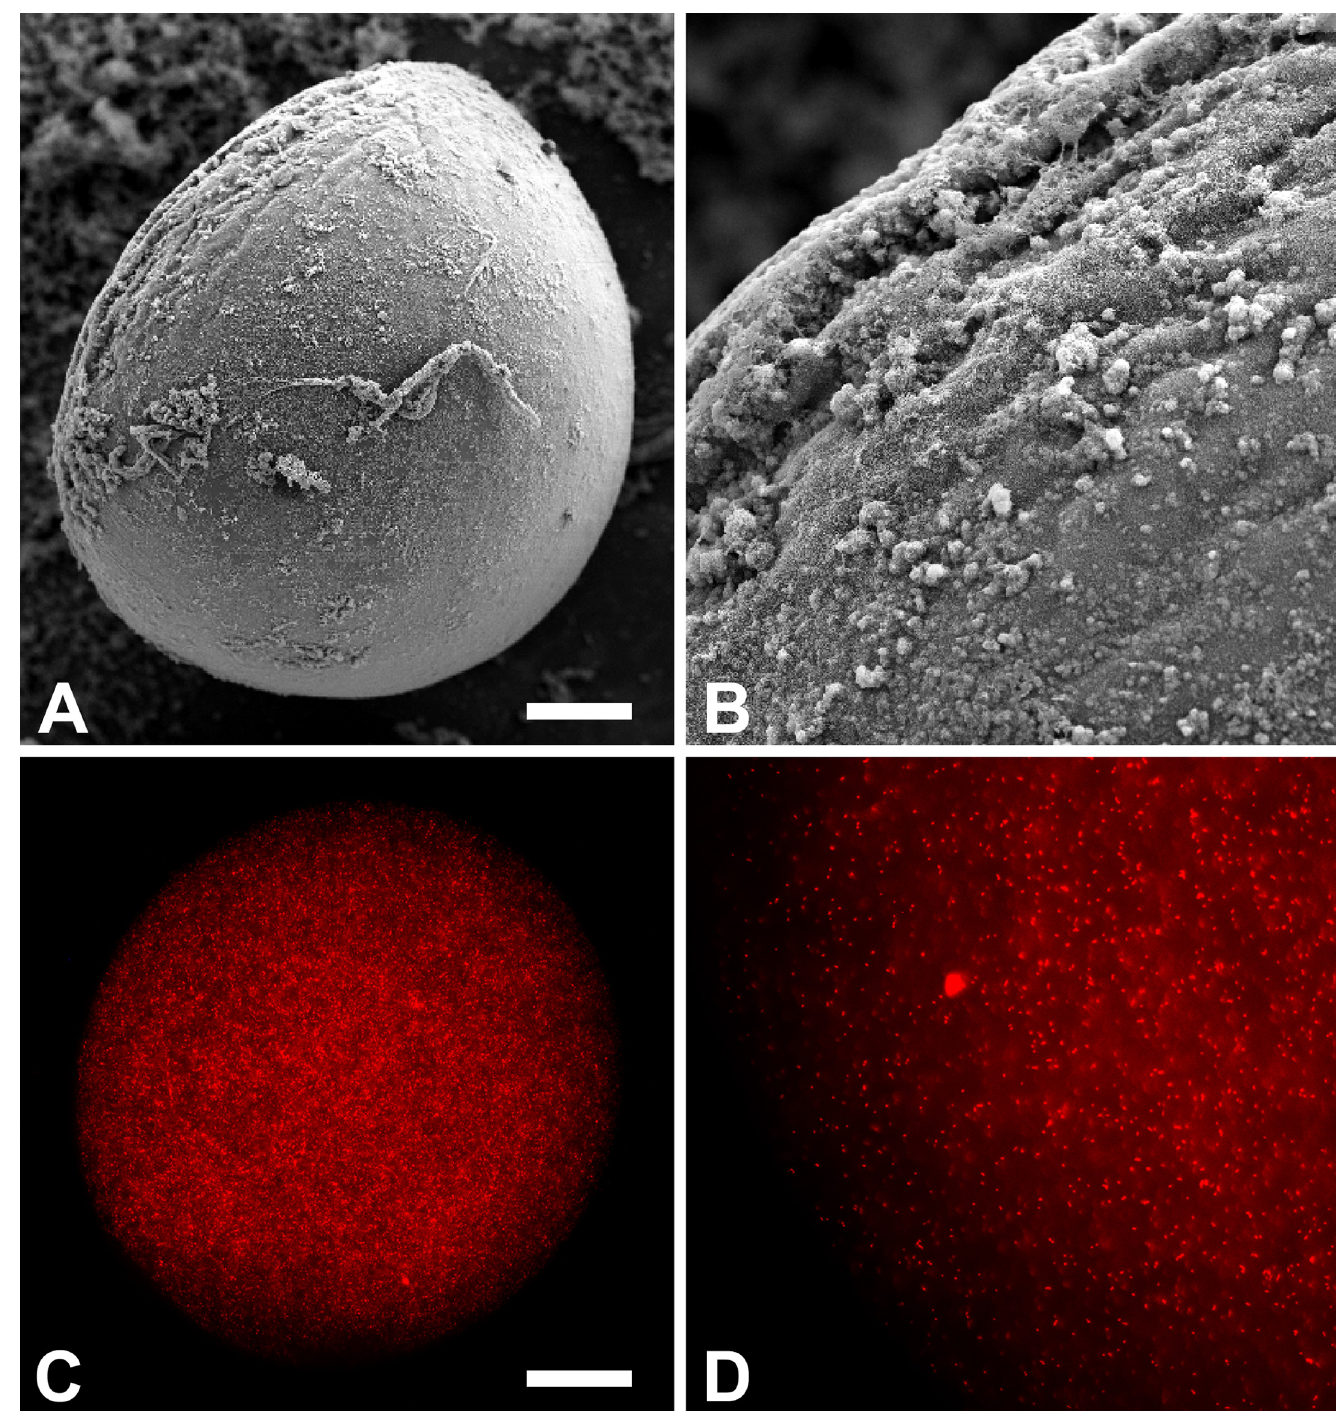
Fig 1. Scanning electron micrograph of alginate capsules, Bar = 100 μ m (A); detail of the surface of the capsule (B); fluorescence microscopy of alginate capsules containing mCherry -expressing Brucella ovis Δ abcBA , Bar = 100 μ m (C). Higher magnification demonstrating individualized mCherry -expressing Brucella ovis Δ abcBA